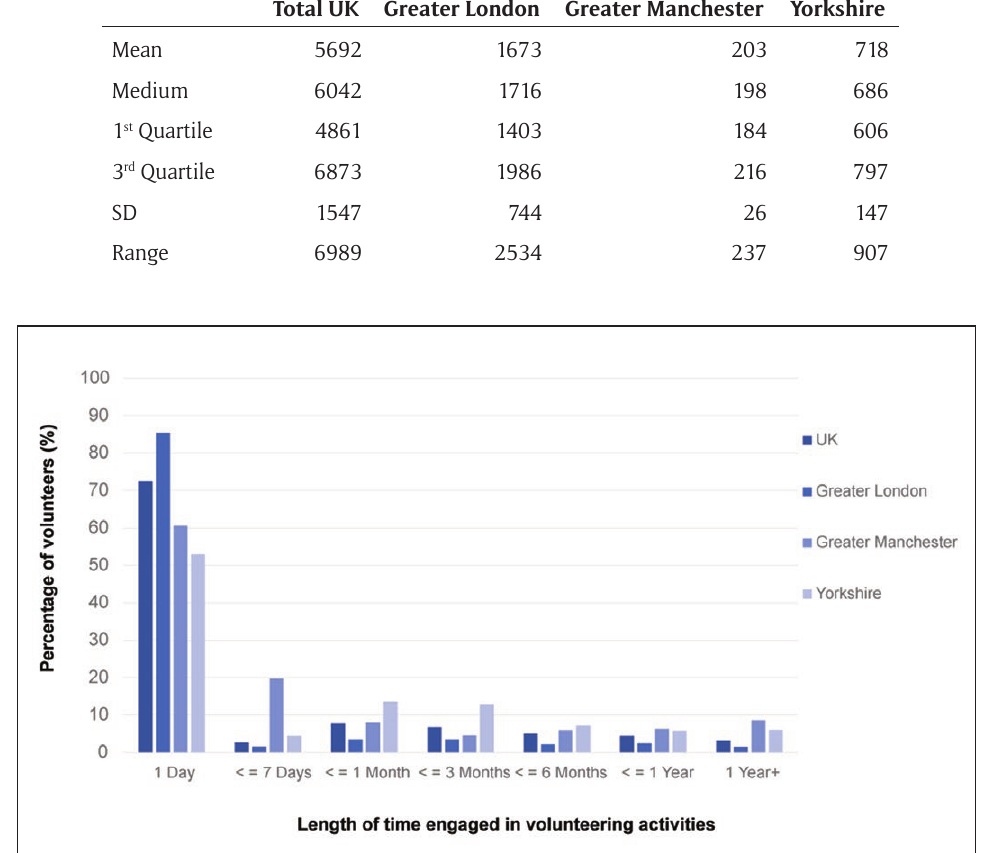
Figure 1: Total percentage of TCV volunteers’ length of time